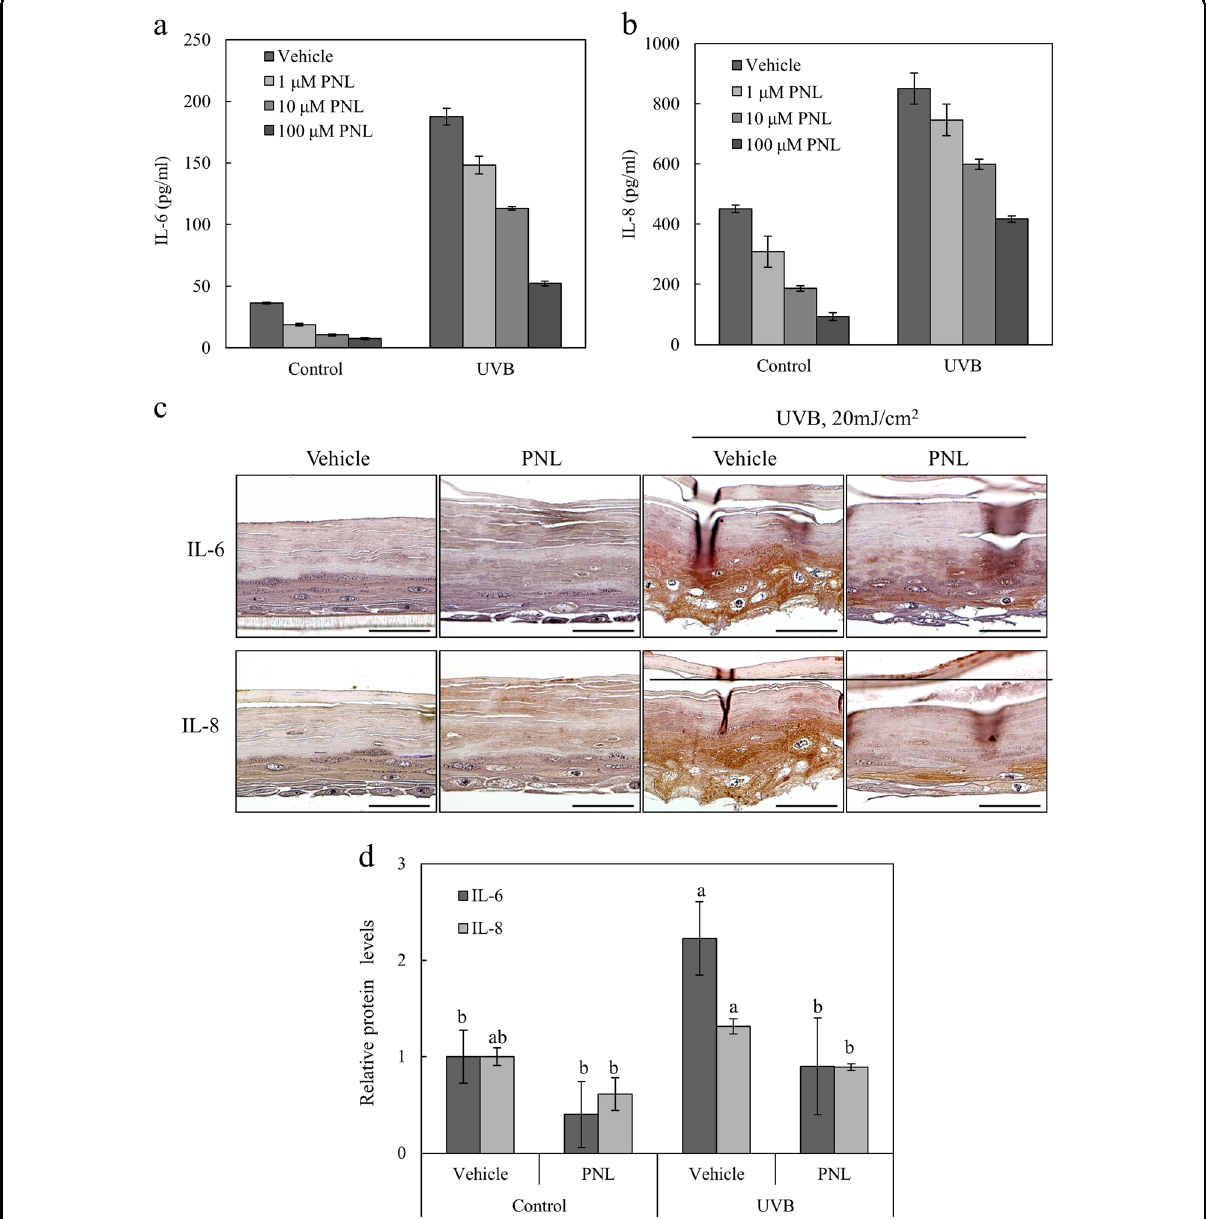
concentrations of propranolol (PNL; 0, 1, 10, and 100 μ M) for 24 h. a , b Secreted IL-6 and IL-8 were detected in culture supernatants using speci fi c ELISA kits. All data (mean± SD) represent three independent experiments. c A reconstituted human skin model was stimulated with 20 mJ/cm 2 UVB, treated with 10 μ M propranolol, and fi xed at 24 h for immunohistochemical analyses. IL-6 and IL-8 levels were determined using each antibody. Scale bars: 50 μ m. d Culture media were analyzed by ELISA kits for IL-6 or IL-8. All data (mean ± SD) represent three independent experiments. Means without a common letter differ; P <